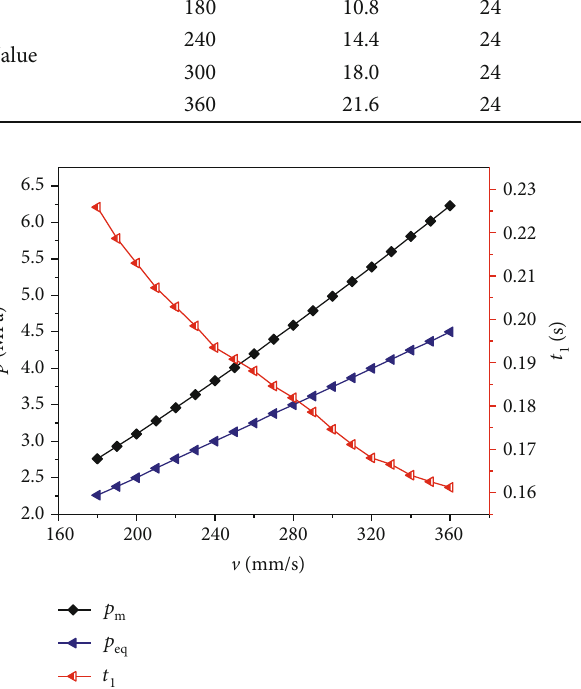
Table 8: The main parameters calculated results for di ff erent fl ow velocities of the pasty propellant. Parameters v (mm/s) v (mm/s) p